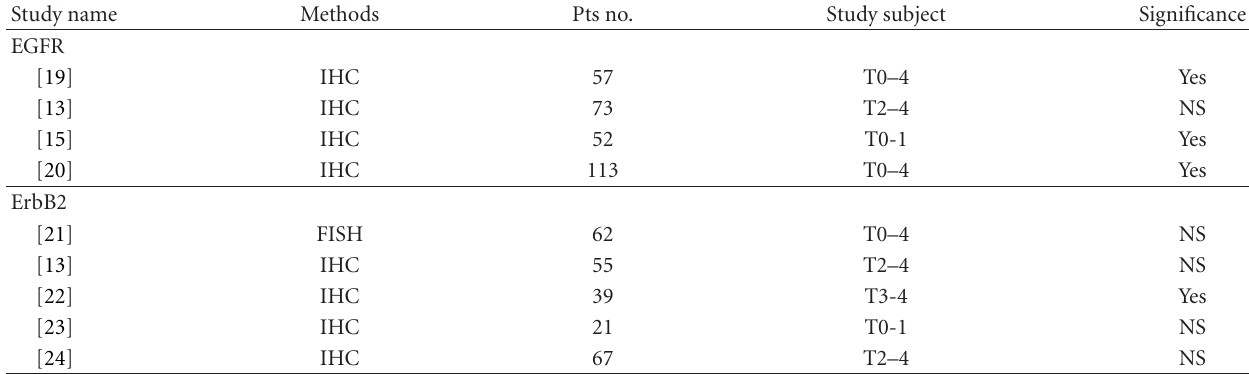
Table 2: Significance of ErbB receptor family as a marker for cancer progression.